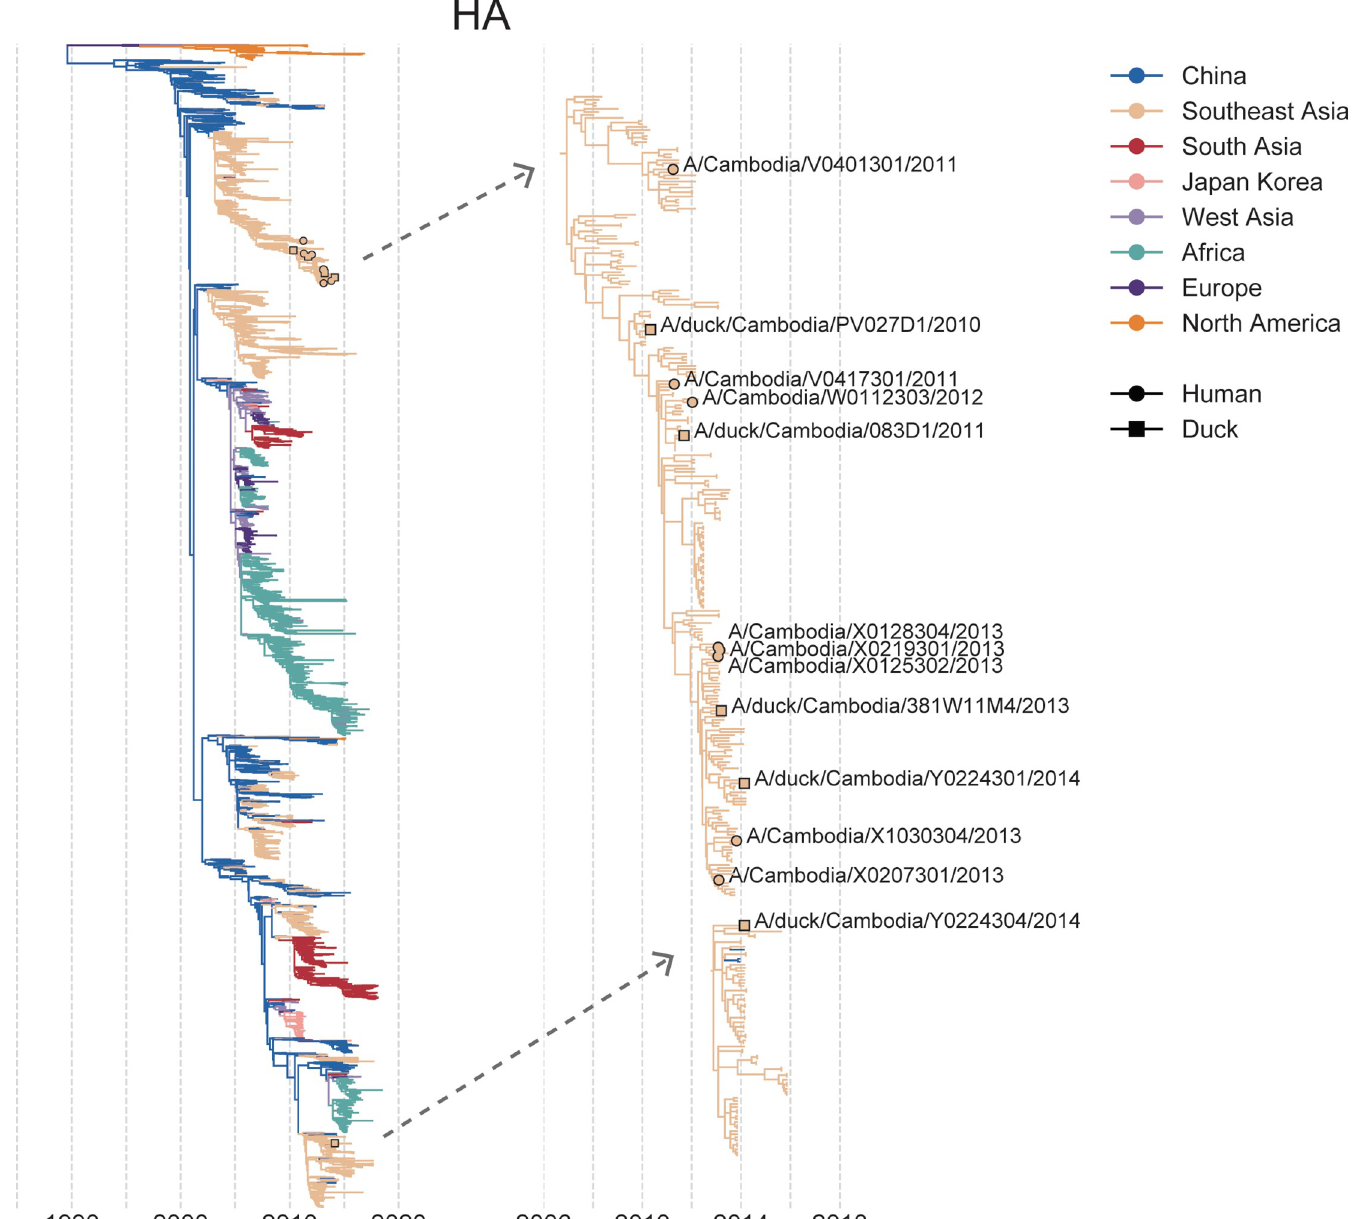
Fig 1. Phylogenetic placement of H5N1 samples from Cambodia. All currently available H5N1 sequences were downloaded from the Influenza Research Database and the Global Initiative on Sharing All Influenza Data and used to generate full genome phylogenies using Nextstrain’s augur pipeline as shown in the trees on the left. Phylogenies for the full genome are shown in S2 Fig . Colors represent the geographic region in which the sample was collected (for tips) or the inferred geographic location (for internal nodes). The x-axis position indicates the date of sample collection (for tips) or the inferred time to the most recent common ancestor (for internal nodes). In the full phylogeny (left), H5N1 viruses from Cambodia selected for within-host analysis are indicated by tan circles with black outlines. The subtrees containing the Cambodian samples selected for within-host analysis are shown to the right and are indicated with grey, dashed arrows. In these trees, human tips are marked with a tan circle with a black outline, while duck tips are denoted with a tan square with a black outline. All samples from our within-host dataset are labelled in the subtrees with their strain name. Internal genes from samples collected prior to 2013 belong to clade 1.1.2, while internal genes from samples collected in 2013 or later belong to clade 2.3.2.1a. All HA and NA sequences in this dataset, besides A/duck/Cambodia/Y0224304/2014, belong to clade 1.1.2.